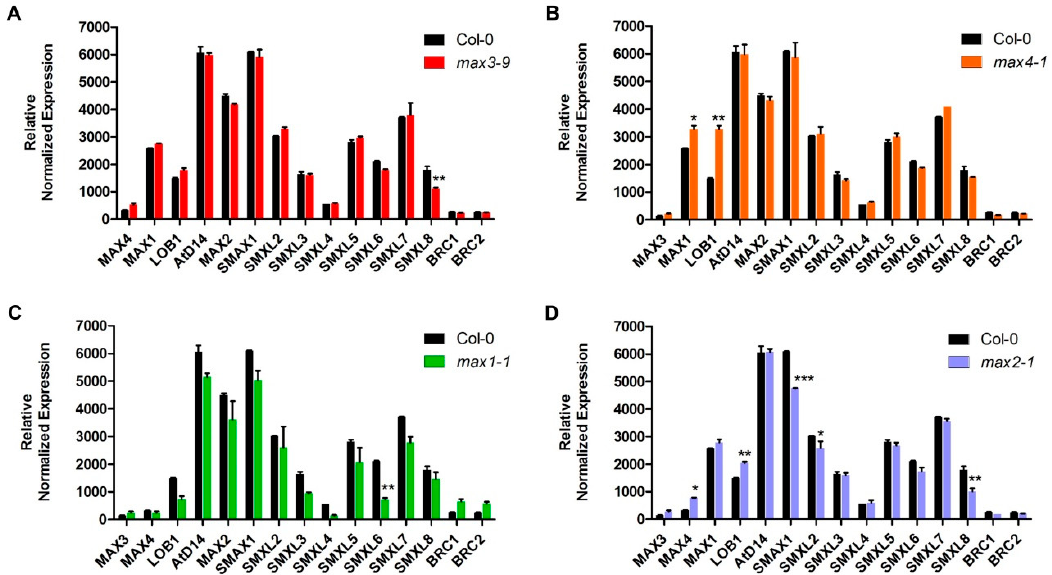
Figure 3. The transcript level of genes involved in strigolactone biosynthesis and signaling pathway in four max mutants. ( A – D ) Relative expression of SL metabolism-related genes in max3-9 , max4-1 , max1-1 , and max2-1 mutant respectively compared with wild-type based on microarray results. Leaf of the mature plant was used to isolate RNA. Each data point represents the mean ( ± SE) from 2 di ff erent plants. The star indicates a significant di ff erence between mutant and wild-type. * p < 0.05, ** p < 0.05, *** p < 0.001 (Two-way ANOVA test).